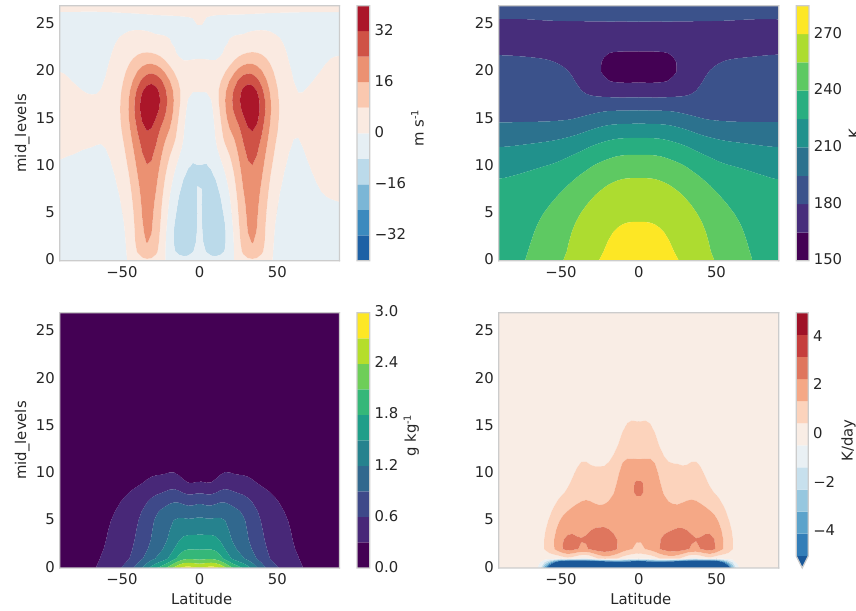
Figure 9. The zonal mean equilibrium profiles in the idealized GCM runs with no seasonal cycle. The plotted fields are, in clockwise order from the top left, the zonal winds, air temperature, convective heating rate, and specific humidity respectively. The y axis is in model levels, and the x axis is in